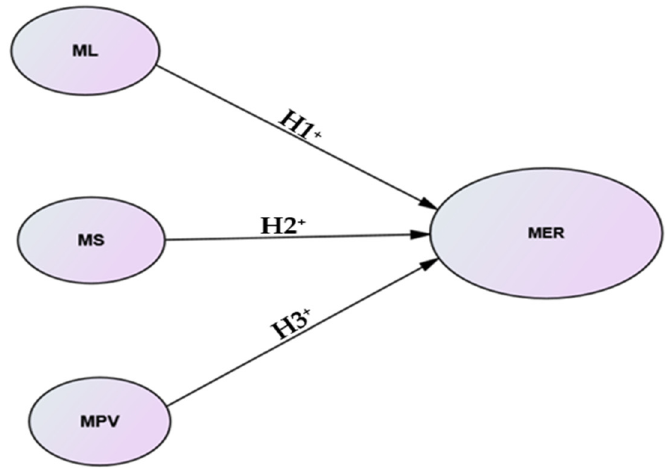
Figure 1. Research